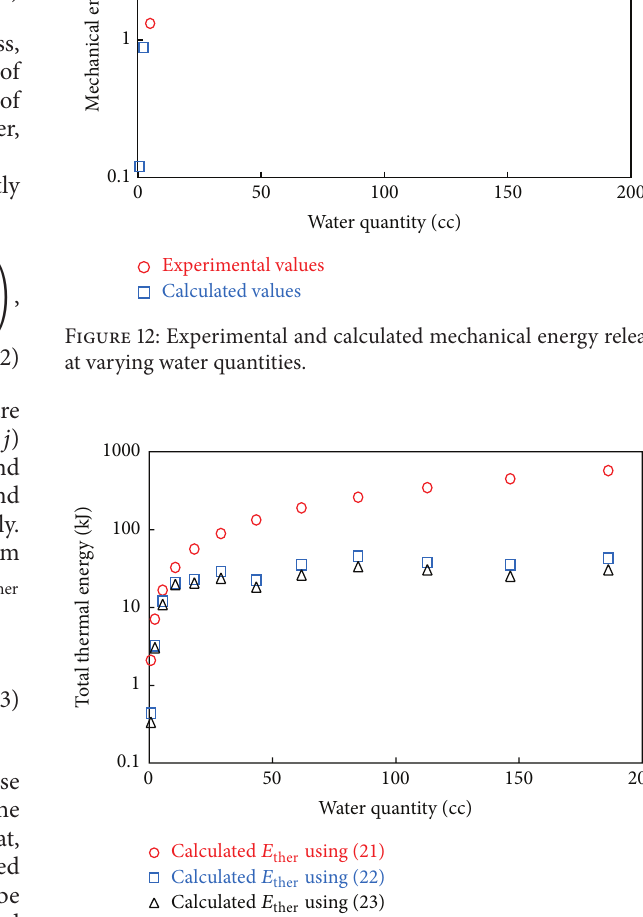
Figure 13: Estimated total thermal energy at varying water quanti-